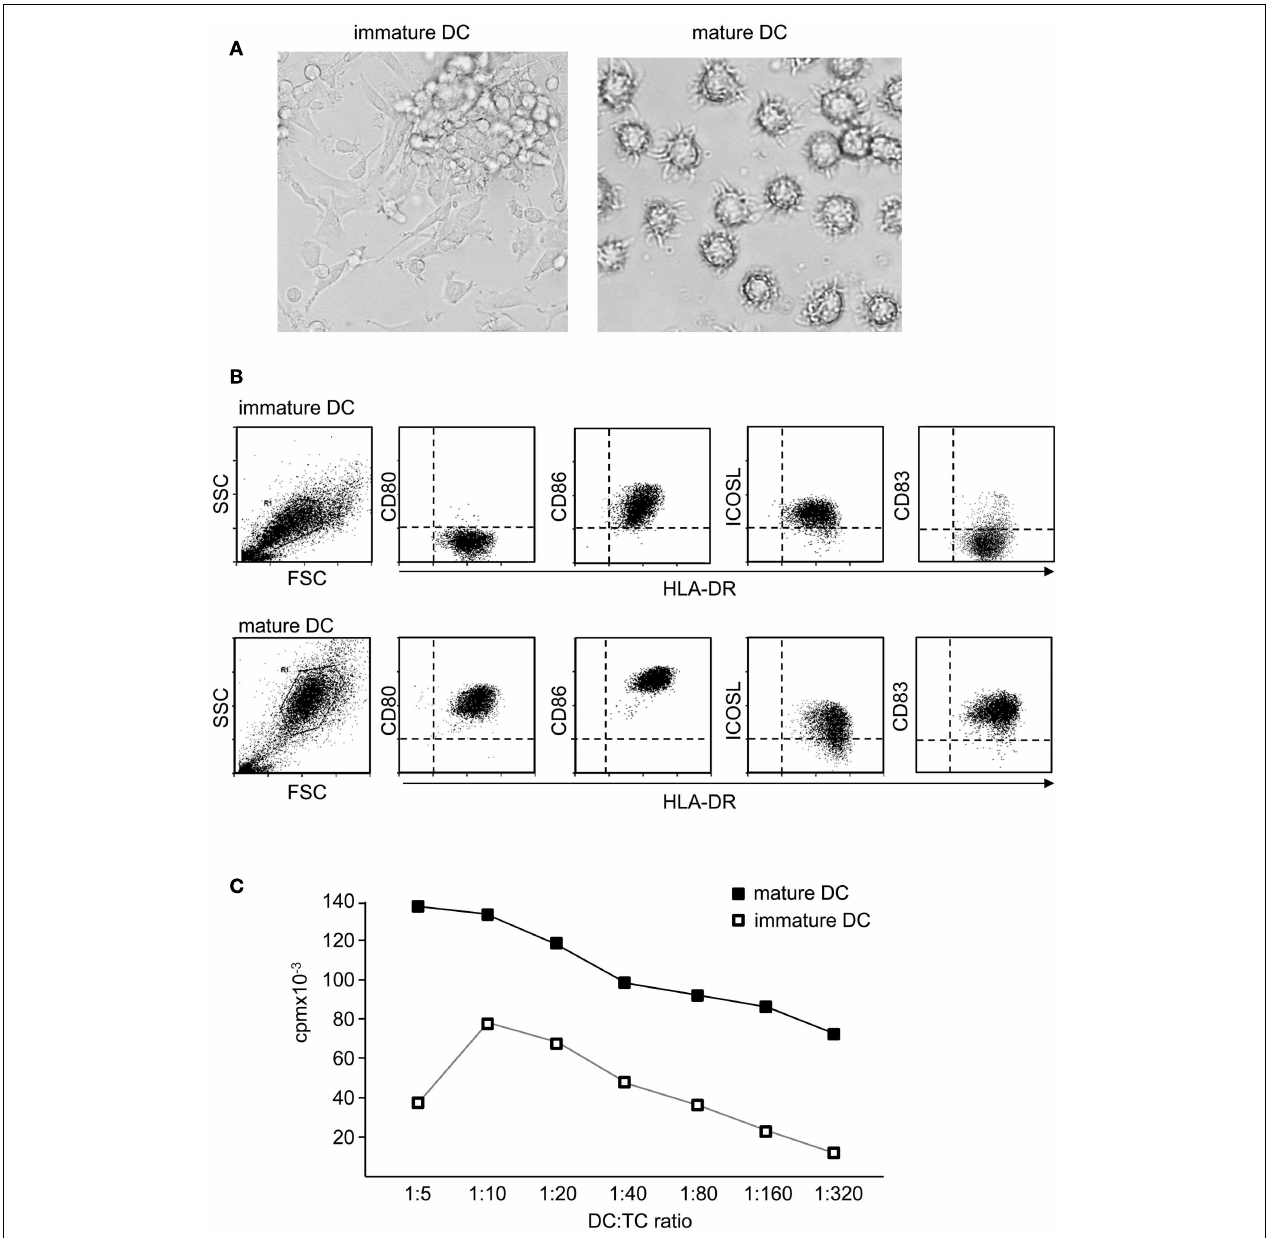
CD86, whereas ICOSL is rather down regulated or unaltered. Also antigen presentation is enhanced, displayed by higher levels of MHC molecules. (C) In coculture with alloreactiveT cells, immature DC induce only comparable weakT cell proliferation, whereas mature DC are potent activators ofT